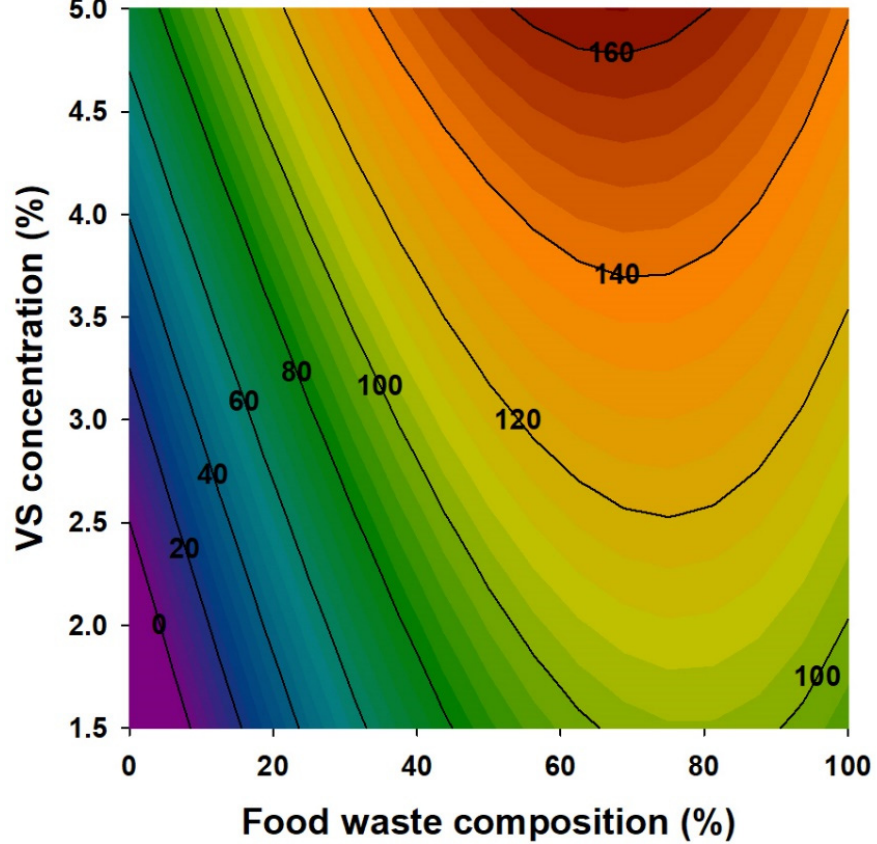
Figure 4. Contour lines of specific hydrogen production rate ( R s , mL H 2 /g VSS/h) against volatile solid (VS) concentration and food waste composition.